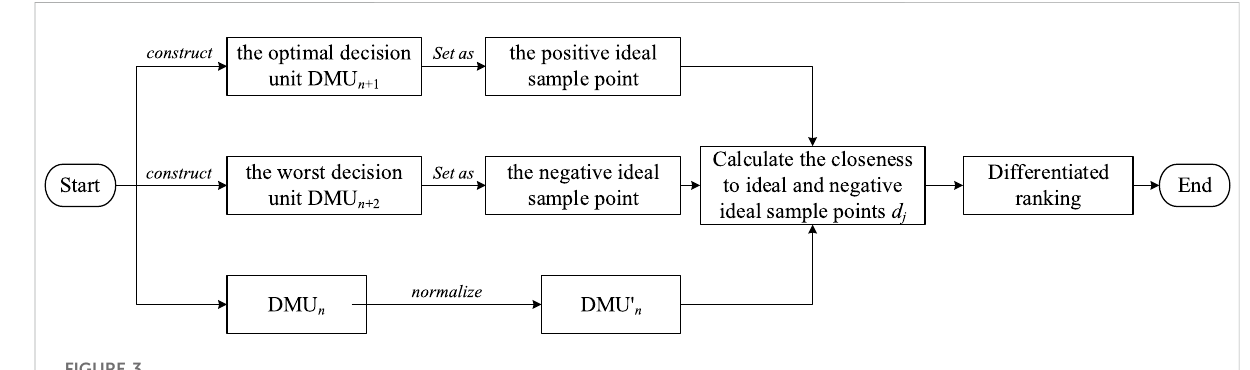
FIGURE 3 The process of differentiated ranking of investment merger ef fi ciency.